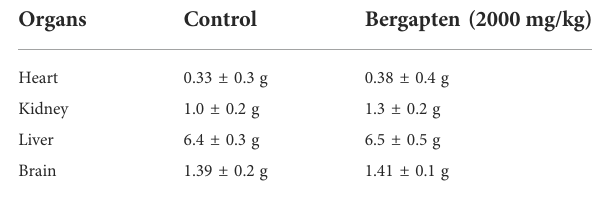
TABLE 5 Effect of bergapten on the organ weight of treated and control rats (at limit dose 2000 mg/kg b.w.